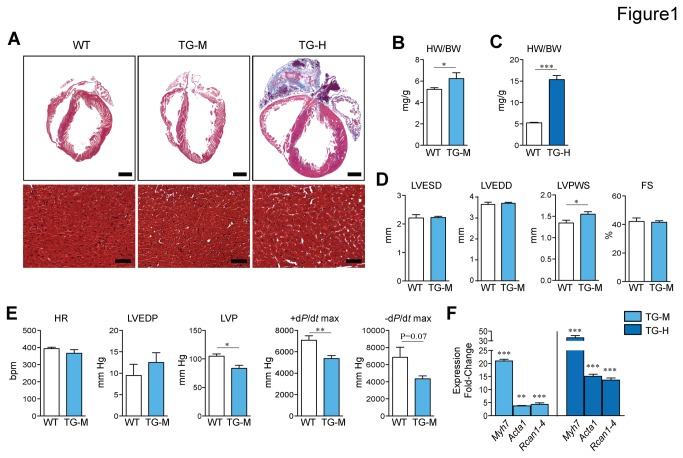
Enforced expression of miR-22 in the heart is sufficient to induce cardiomyopathy.(A) Representative hearts of TG-M, TG-H and non-transgenic (WT) mice at 12-weeks of age. Top and bottom panels show Masson’s Trichrome stained sections at low and high magnification respectively (Scale bars: 1mm and 50mm). (B,C) Heart weight normalized to body weight (HW/BW) in 12-week old TG-M and TG-H mice versus WT (n = 5-12). (D) Analyses of cardiac function by echocardiography in 12-week old TG-M and WT mice. LVESD, LV end-systolic dimension; LVEDD, LV end-diastolic dimension; LVPWS, LV posterior wall thickness at end-systole; FS, fractional shortening (n = 10-11). (E) Hemodynamic analysis with a Millar catheter in 12-week old TG-M and WT mice. HR, heart rate; LVEDP, LV end-diastolic pressure; LVP, maximal LV pressure; +dP/dt max, maximal contraction rate; -dP/dt max, maximal relaxation rate (n = 5). (F) Relative mRNA expression levels of indicated genes in 12-week old TG-M and WT mice. Bars represent expression normalized with WT set equal to 1.0 (n = 3-4). Student t test. *, P<0.05; **, P<0.01; ***, P<0.001.